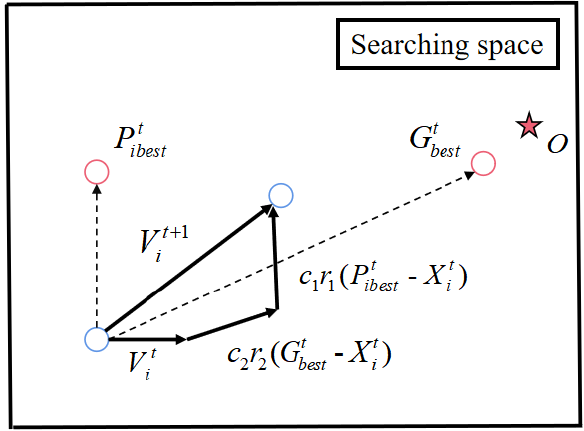
Figure 2. Optimization process of particles in search space.